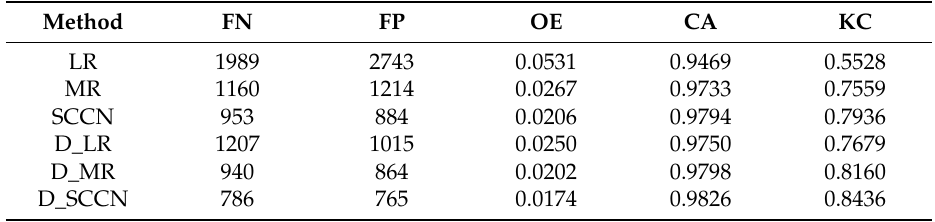
Table 1. Values of the evaluation criteria on the farmland dataset by different methods and these methods based on the deep capsule